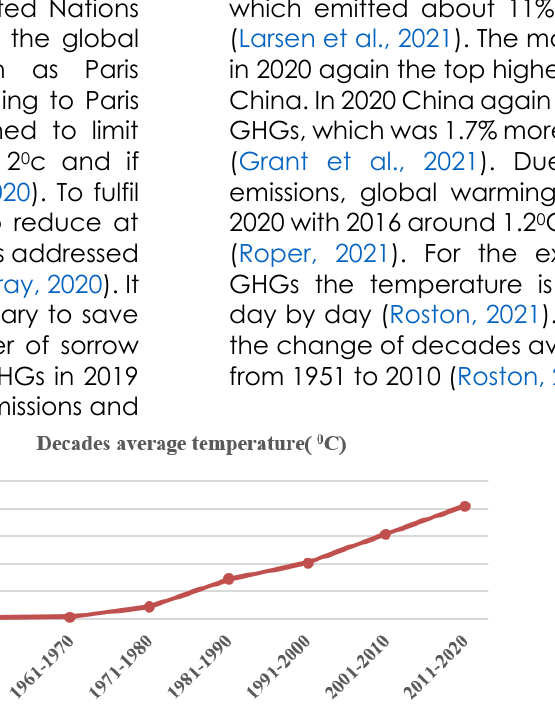
Figure 2. The rising rate of temperature from 1951 to